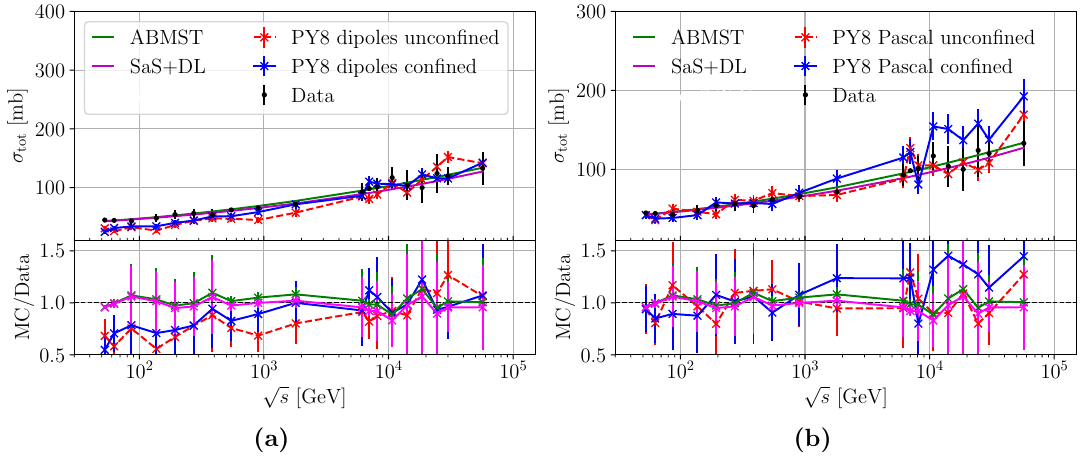
Figure 8. The total pp cross section as a function of p s for the dipole (a) and Pascal (b) models. Both show the con(cid:12)ned and uncon(cid:12)ned versions in solid blue and dashed red lines, respectively. Both (cid:12)gures show the ABMST (solid green lines) and SaS+DL (solid magenta lines) for